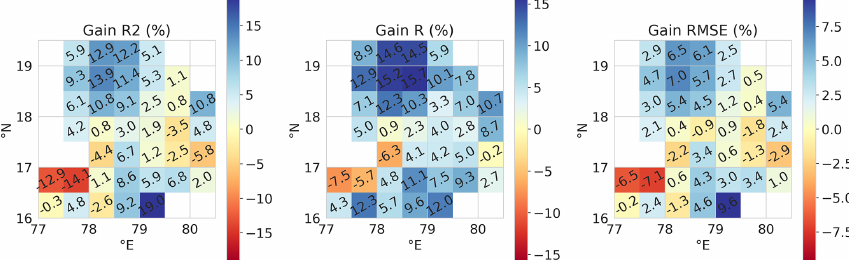
Figure 5. Spatial distribution of the gains of R 2 , R , and RMSE for the downscaling with RF CORR. The numerical value of the metric is indicated on the grid. The abscissa is the east longitude and the ordinate the north latitude.